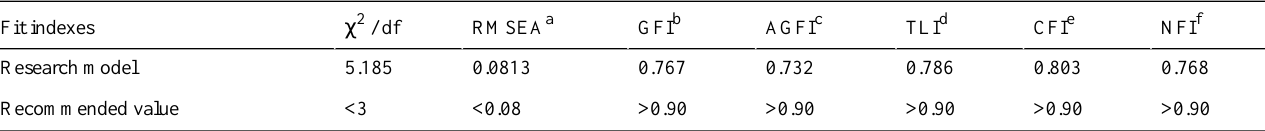
Table 3. Goodness-of-fit results of the research